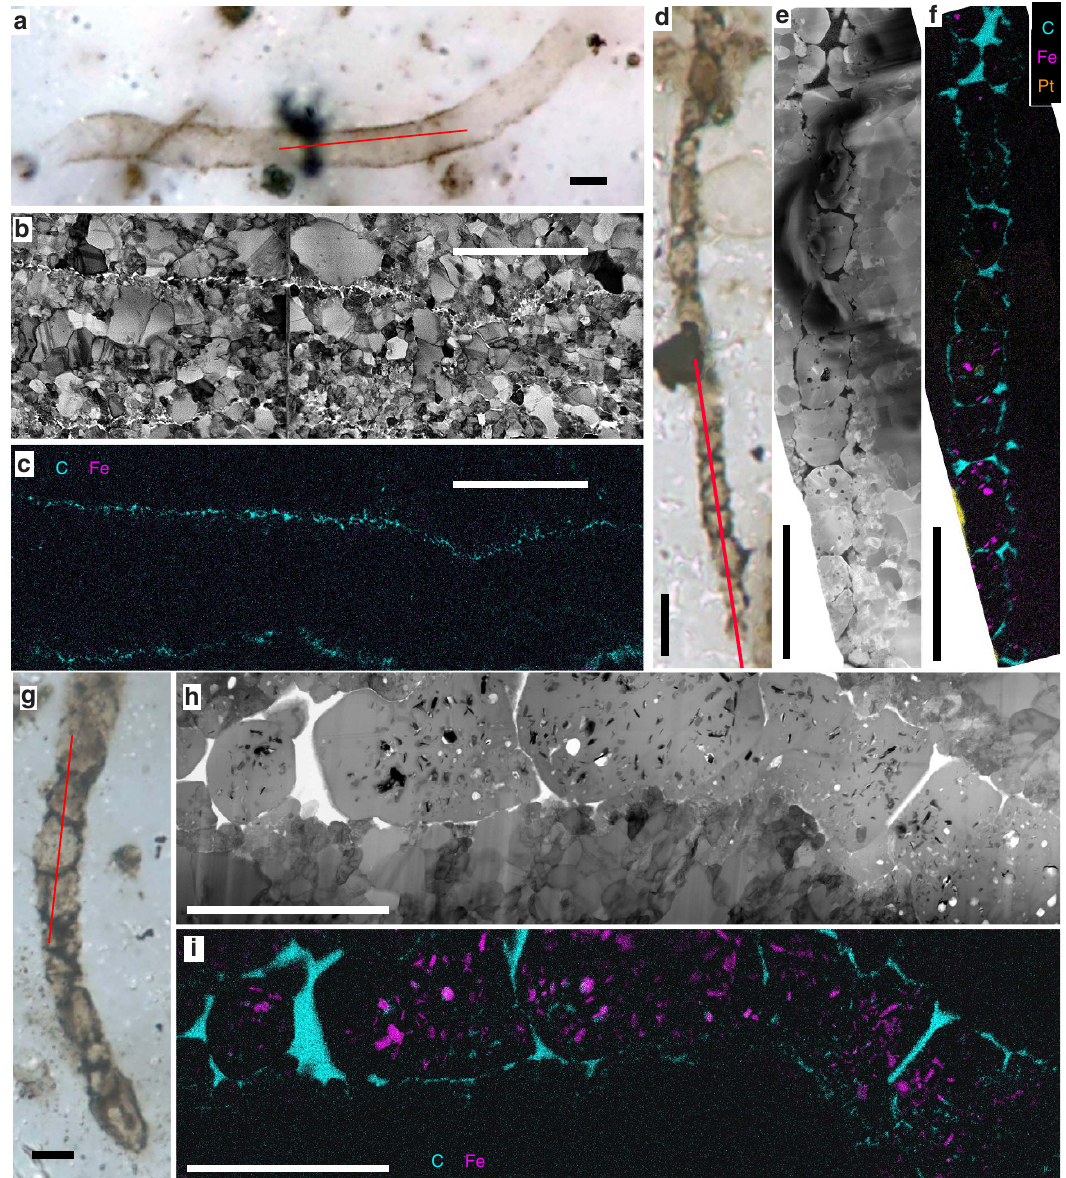
Figure 2 | Iron in Gunflint filaments. Scale bars, 5 m m. ( a – c ) Animikiea of Type 1 (without cell remnants in sheath). ( d – f ) G. minuta of Type 2 (with cell-like segmentation). ( g – i ) Type 2 G. grandis. ( a , d , g ) Multiplane photomicrographs. ( b , e , h ) STEM bright- ( b , h ) and dark- ( e ) field images of the FIB ultrathin sections cut along the red lines. ( c , f , i ) STEM maps of Fe (pink), C (cyan) and preparation coatings (Pt: orange); corresponding maps of Si, O and S are shown in Supplementary Fig. 7. Fe minerals occur in G. grandis and G. minuta Type 2, but not in Animikiea . Fe minerals are absent in the vicinity of these